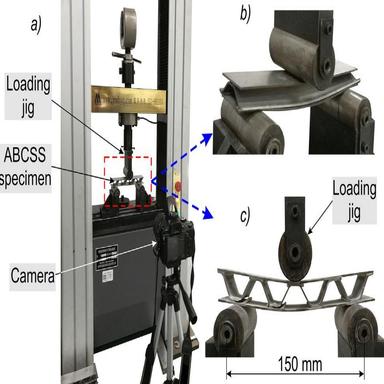
Three-point bending test of the ABCSS: a) Testing configuration; b) Longitudinal and c) Transverse loading directions.